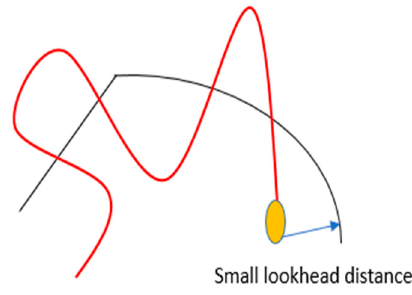
Figure 8. Small look-ahead distance.